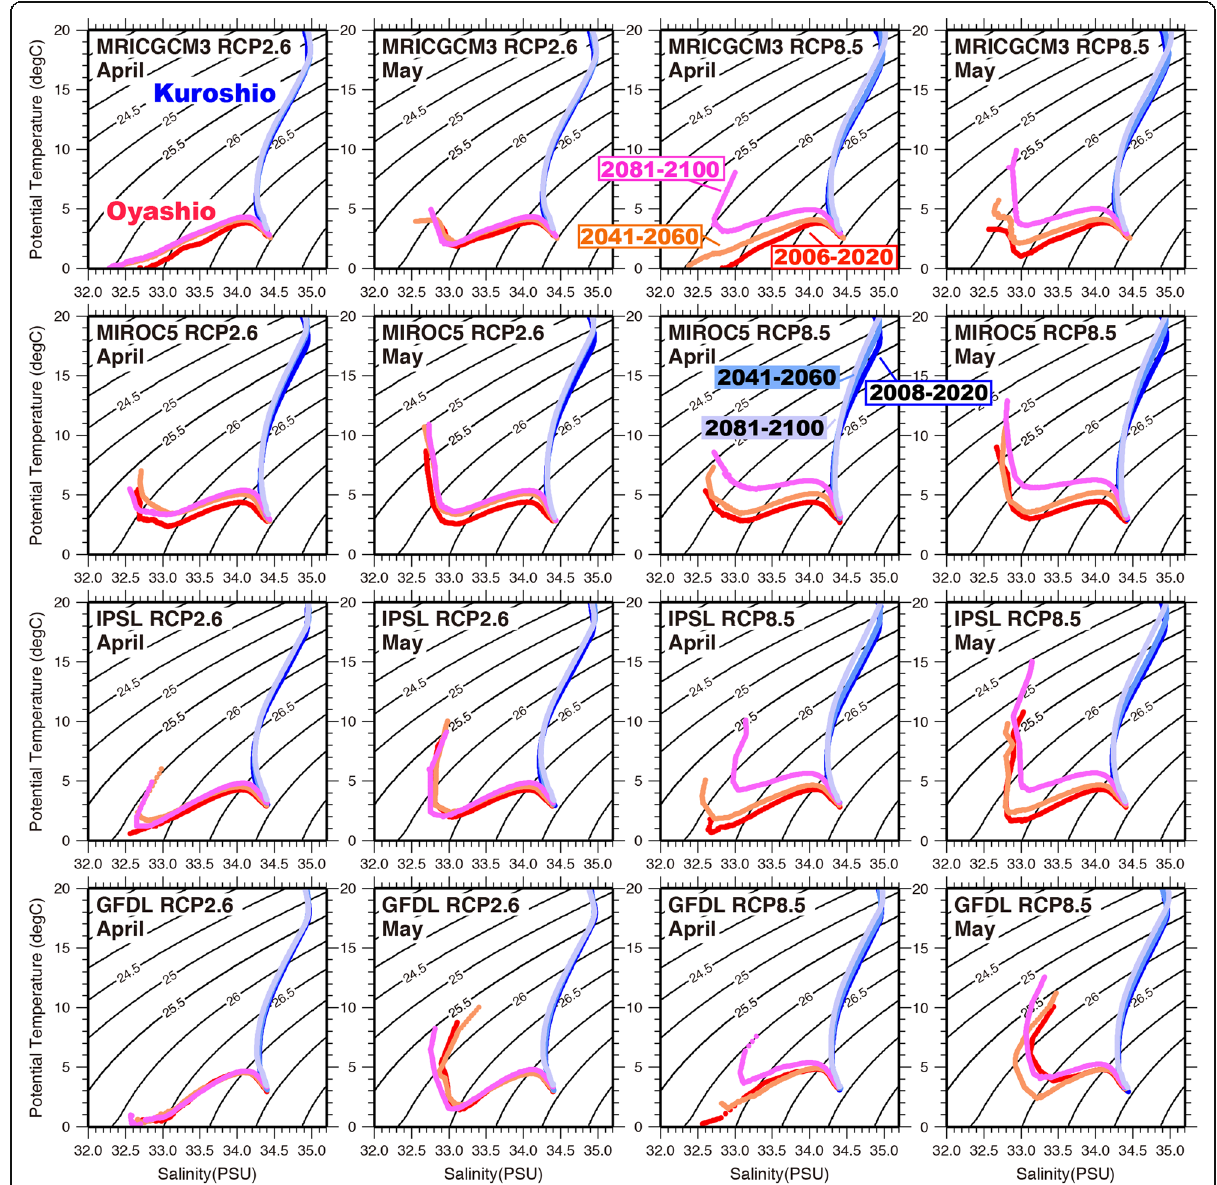
Fig. 6 TS profiles of the pure Oyashio waters (blue) and Kuroshio waters (red) in April and May with four models and two scenarios. Each curve